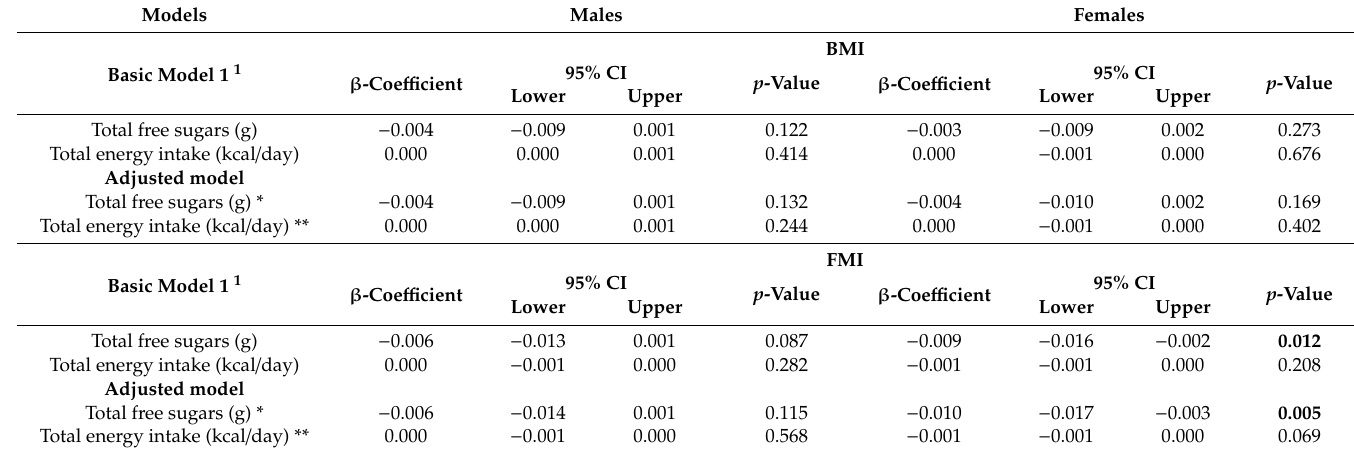
Table 3. Mixed model analysis for total free sugars intake and their association with BMI and FMI in both genders. Models Males Females BMI 95% Basic Model 1 1 β -Coe ffi cient